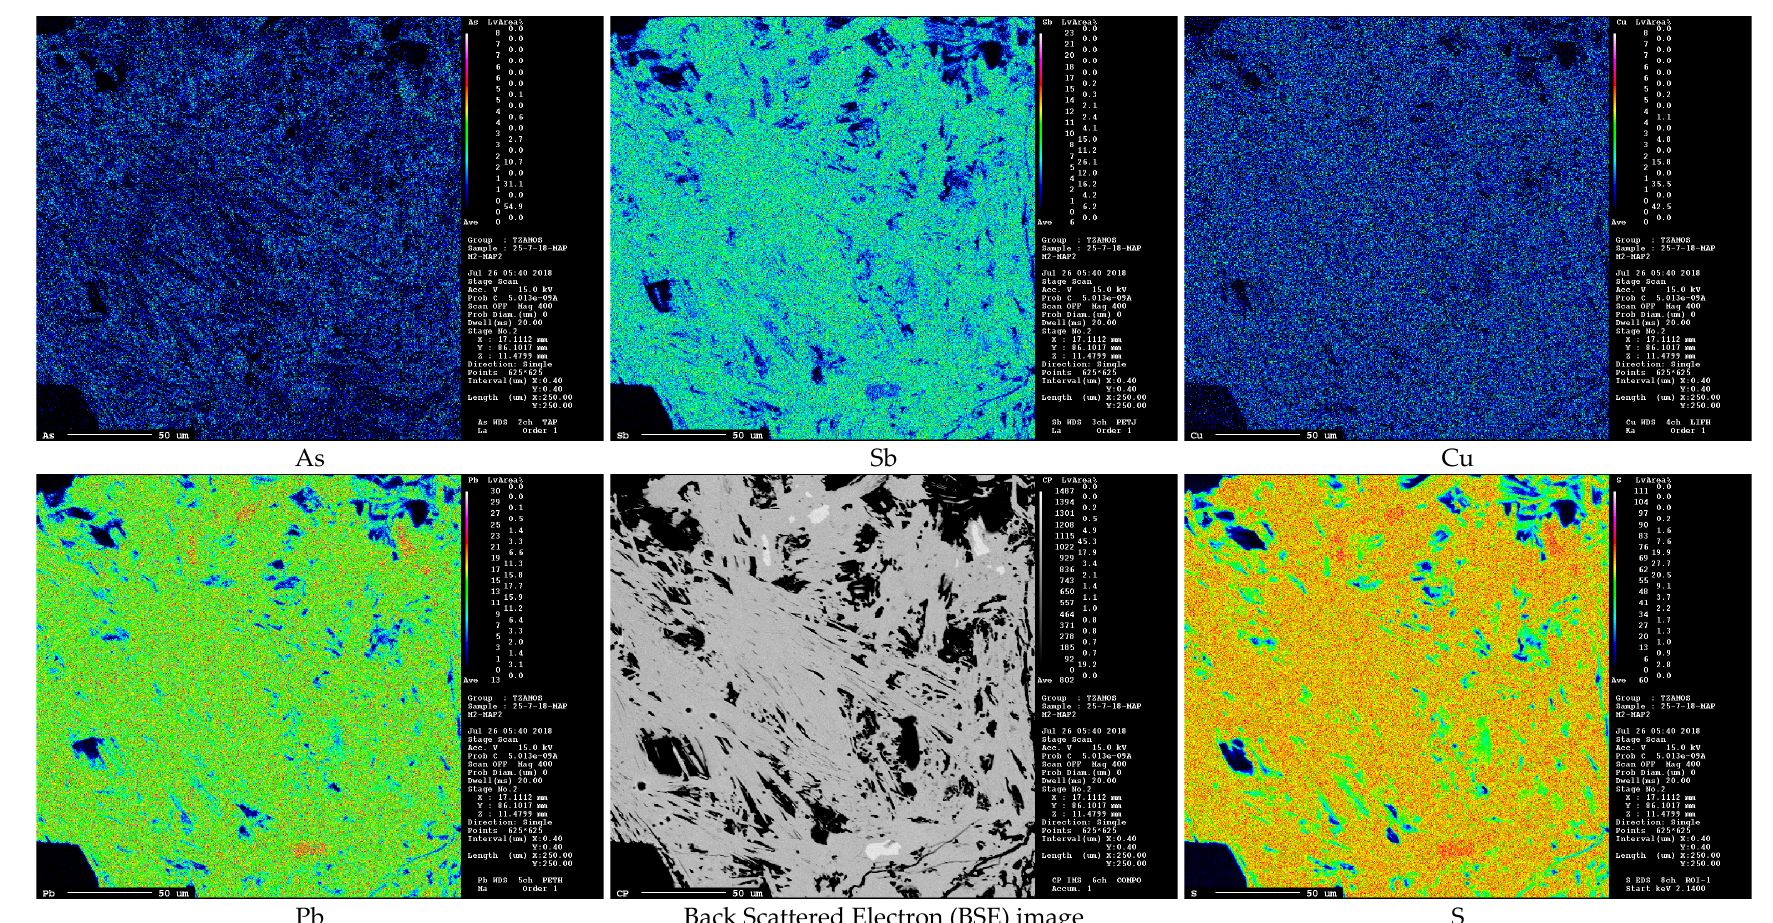
Figure 5. EPMA elemental maps for the Olympiada Sb minerals (unit of scale bar: um=μm).